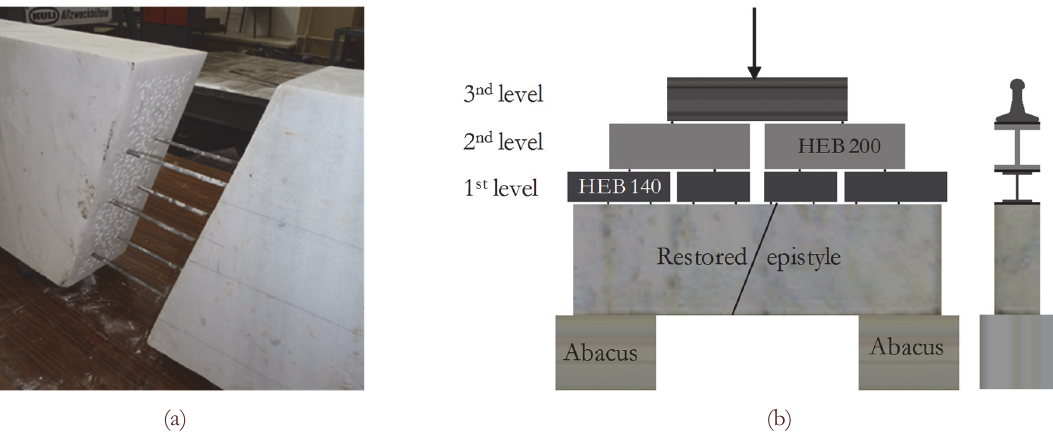
Figure 1: (a) The two fragments of the epistyle’s copy during the restoration phase. The three pairs of reinforcing elements are clearly visible; (b) Schematic representation of the multi-point bending loading